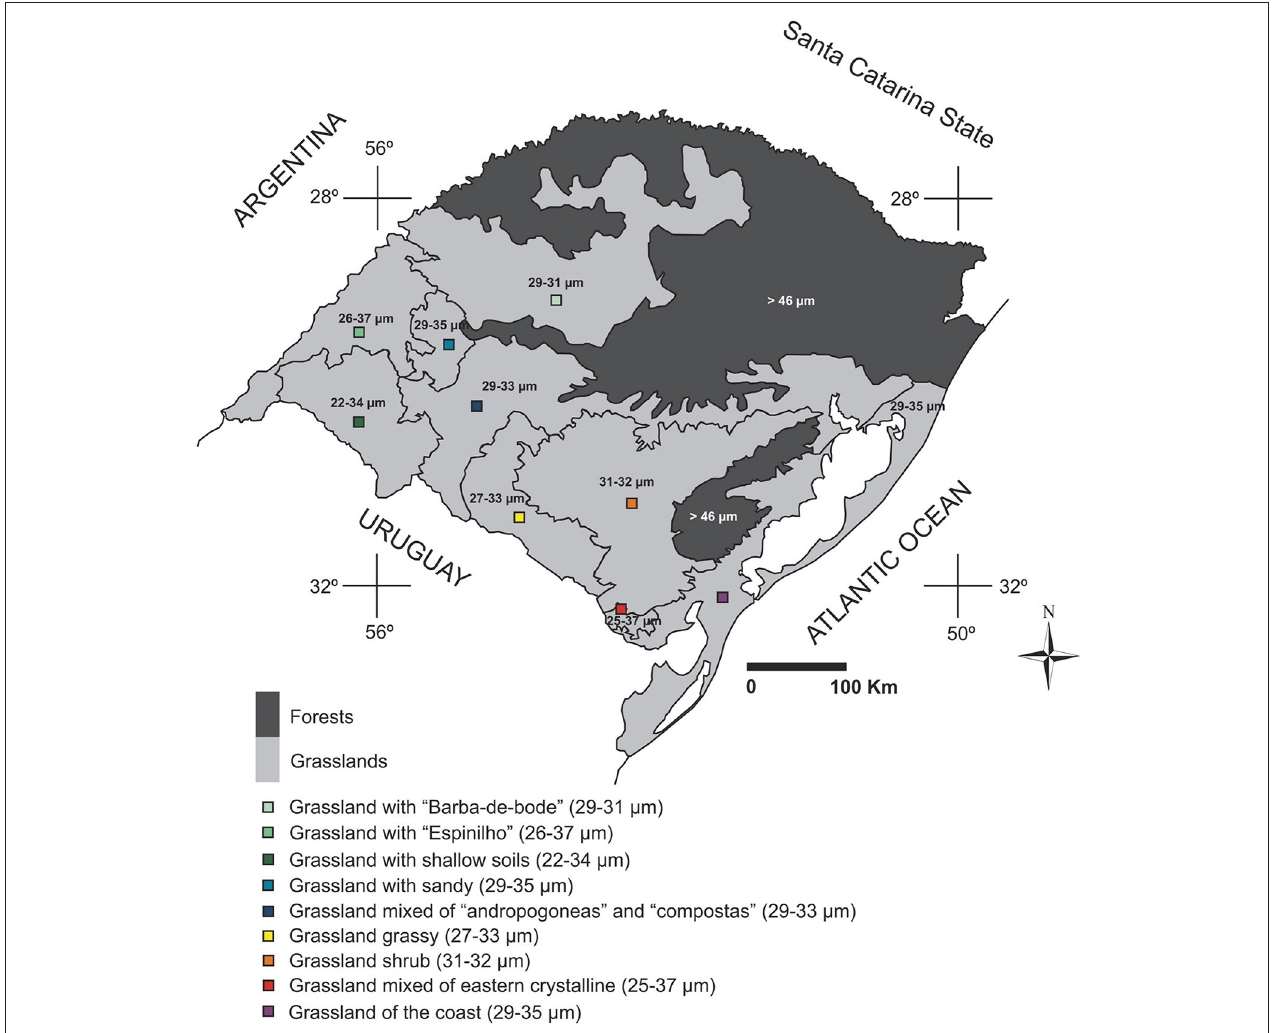
FIGURE 13 | Main changes in the average size of the Poaceae pollen grains in the different regions of Rio Grande do Sul, according to the vegetation physiognomies in RS (adapted from Hasenack et al., 2010).